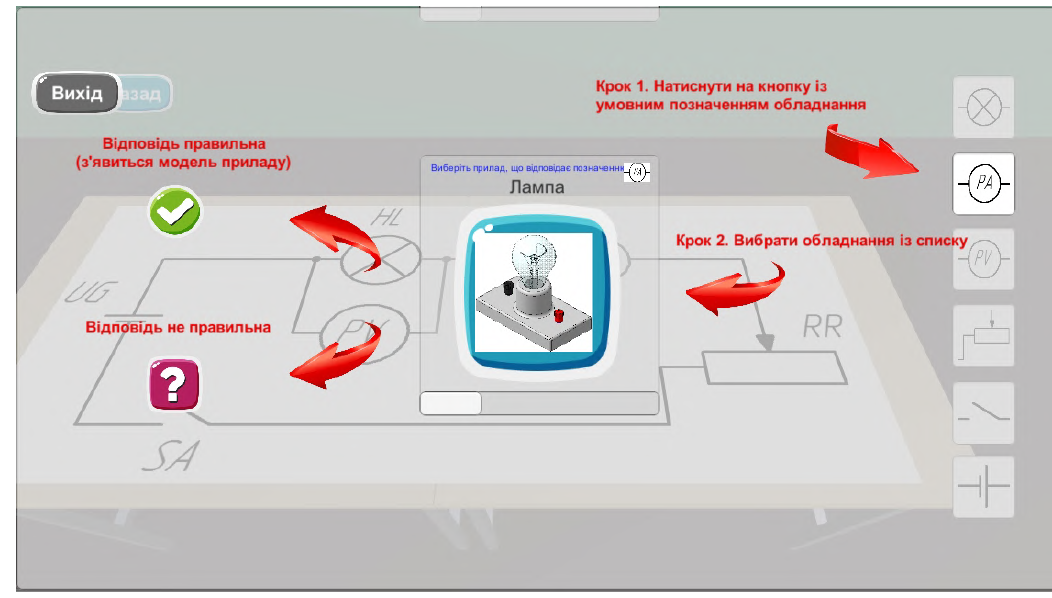
Figure 9: Operation scheme of the theory checks scene.